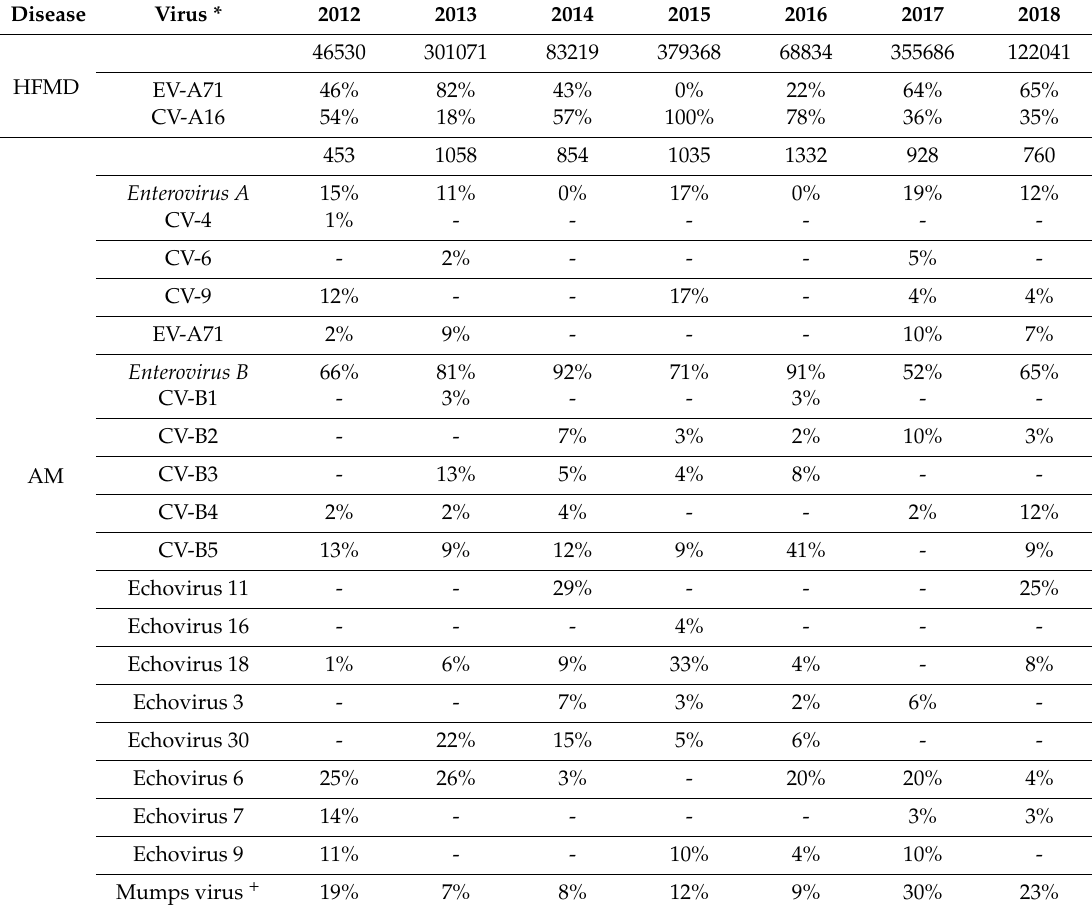
Table 1. HFMD and aseptic meningitis (AM) cases detected per year and the causative agents.